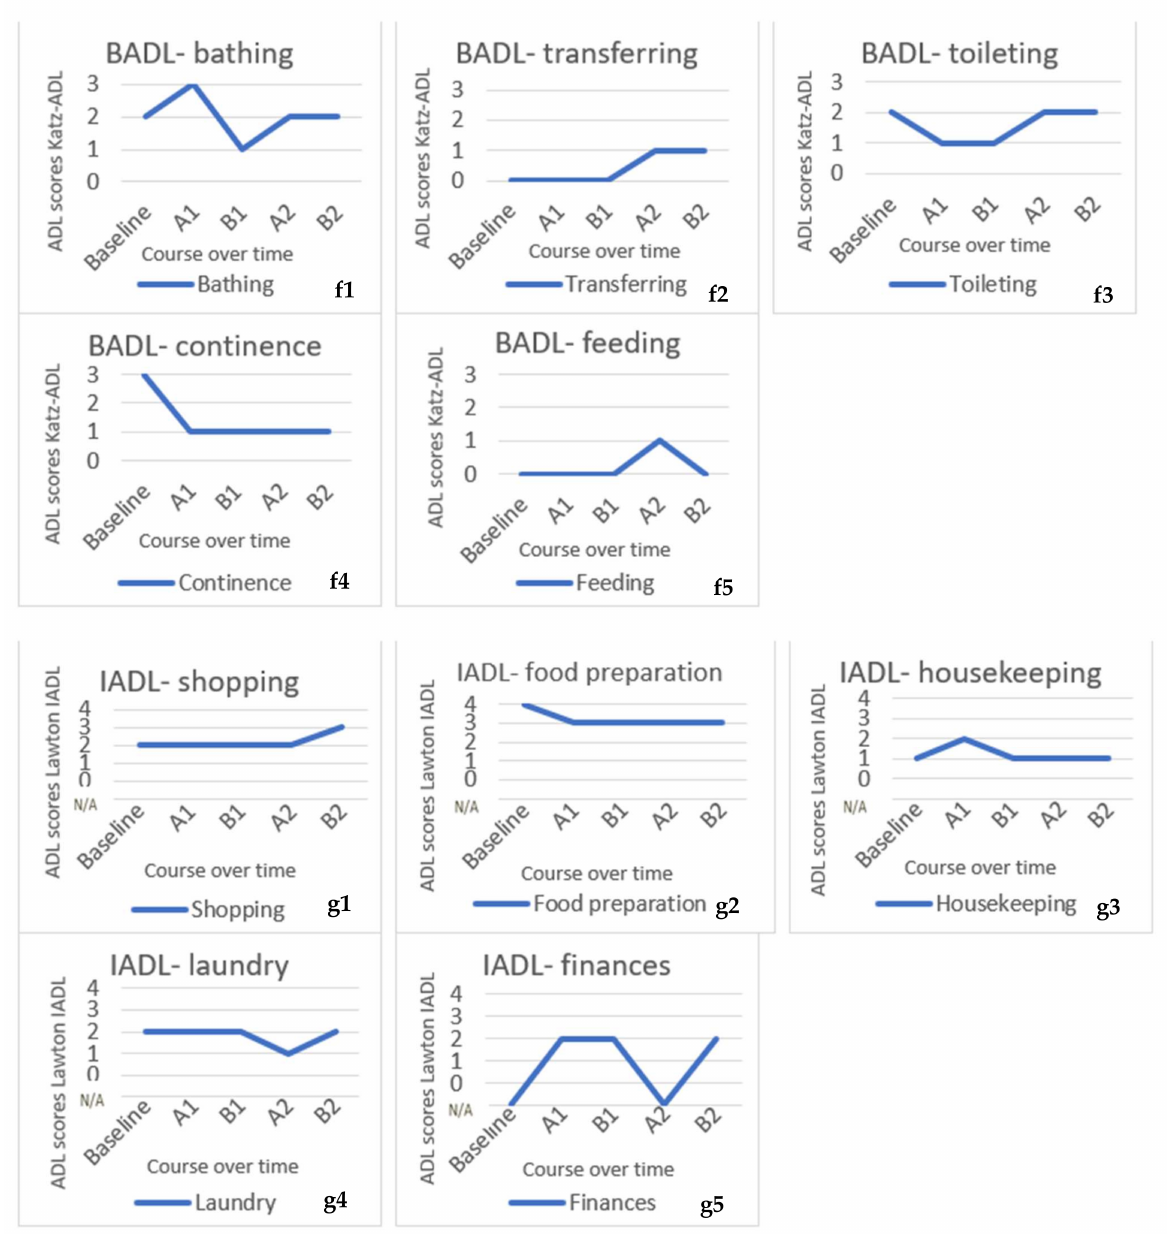
Figure 9. ( a ) Scores washing; ( b ) Scores dressing; ( c ) Scores eating; ( d ) Scores visiting toilet; ( e ) Scores medication intake; ( f1 – f5 ) Scores Katz-ADL; Baseline = before start of the first phase; B1 = scores at the end of intervention phase one; A1 = scores at the end of placebo phase one; B2 = scores at the end of intervention phase two; A2 = scores at the end of placebo phase two; ( g1 – g5 ) Scores Lawton IADL; Baseline = before start of the first phase; B1 = scores at the end of intervention phase one; A1 = scores at the end of placebo phase one; B2 = scores at the end of intervention phase two; A2 = scores at the end of placebo phase